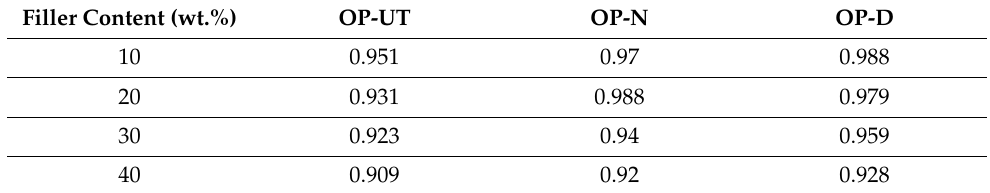
Table 3. Density of developed biocomposites.